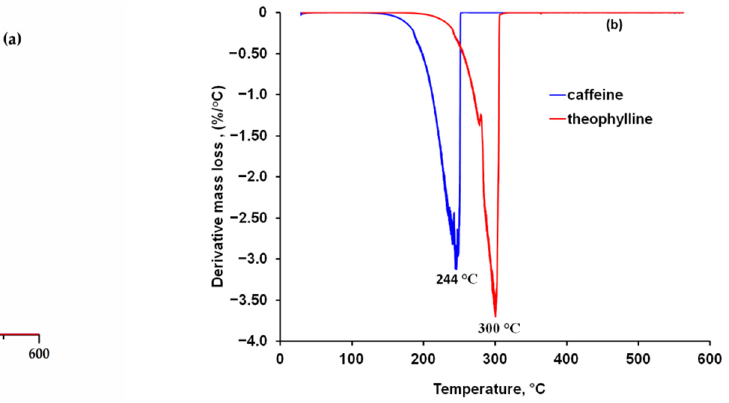
Figure 1. TG ( a ) and DTG ( b ) curves.